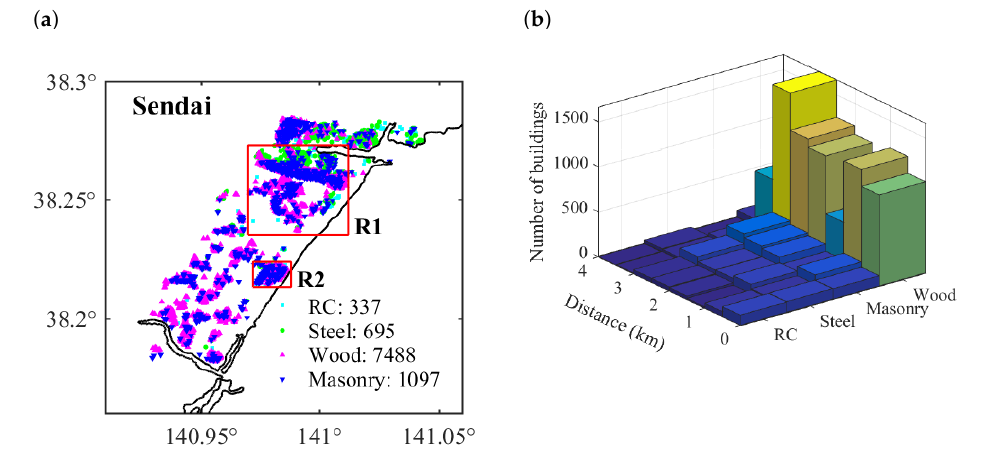
Figure 5. Building portfolio of Sendai: ( a ) building distribution; and ( b ) number of buildings by distance from the coastline.